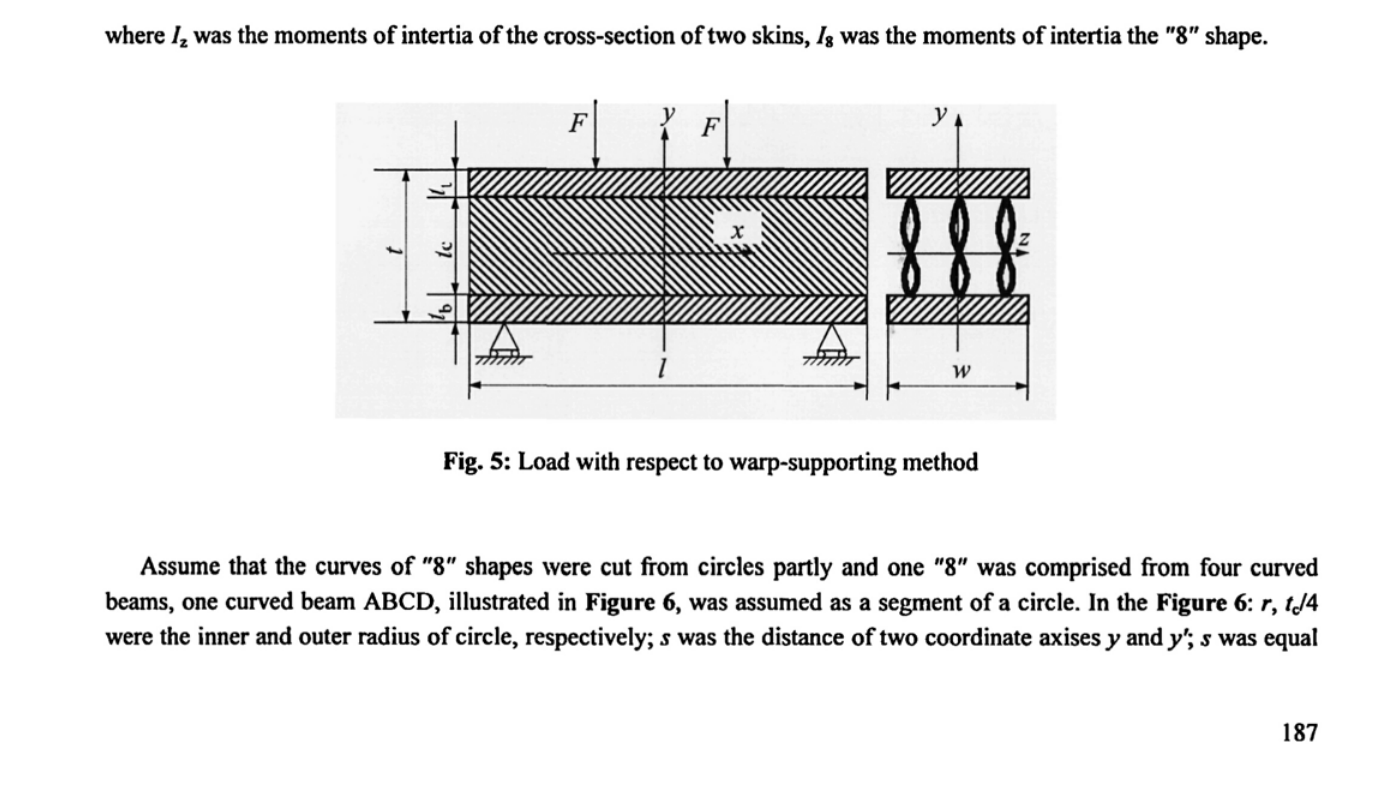
Fig. 5: Load with respect to warp-supporting